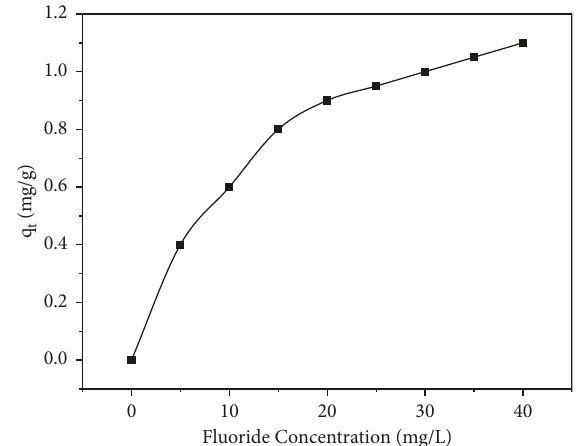
Figure 10: Effect of adsorbent dosage on fluoride ion